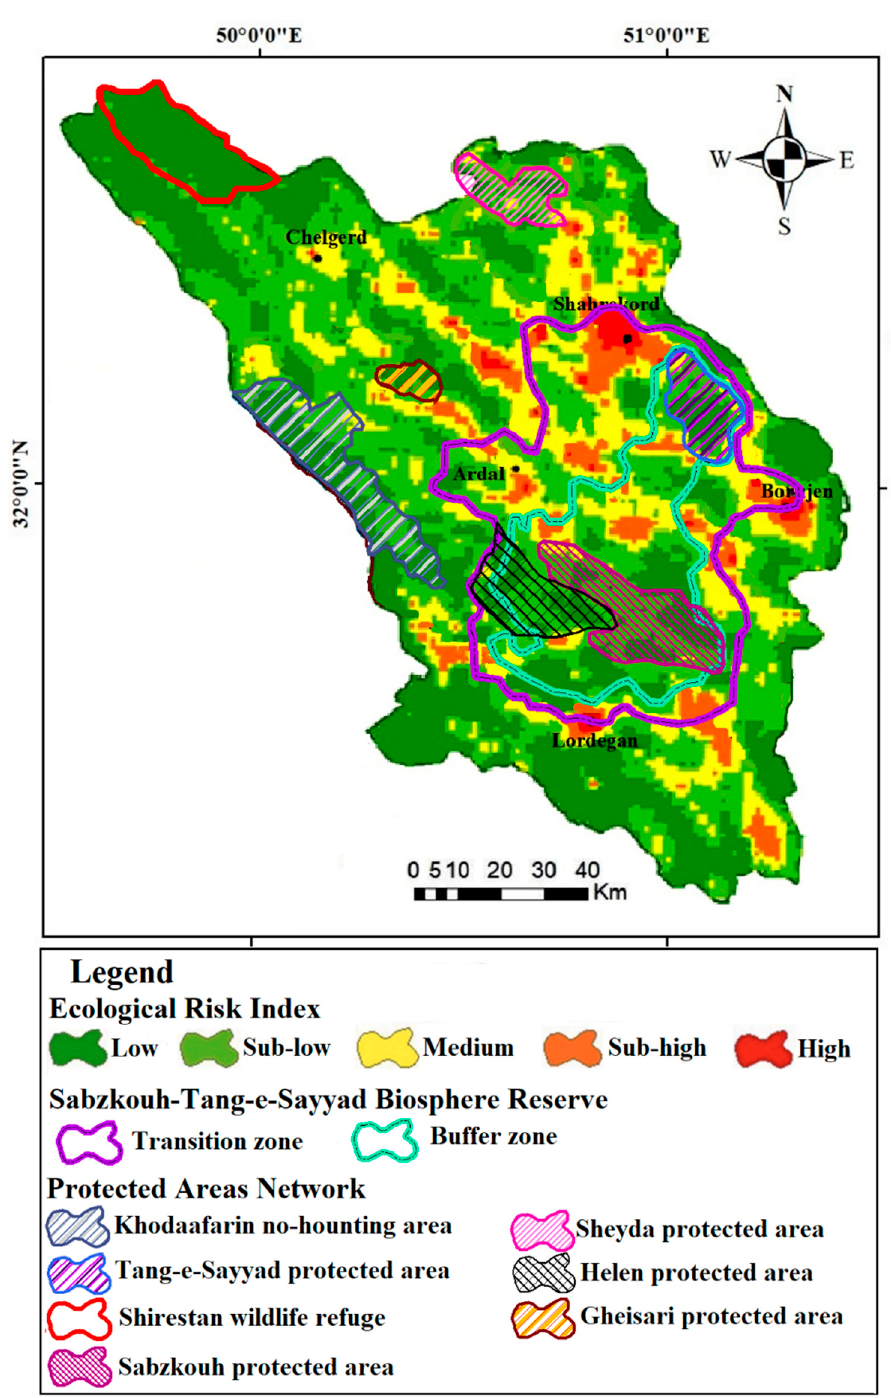
Figure 8. The map overlay of the ERI and protected area network layers.